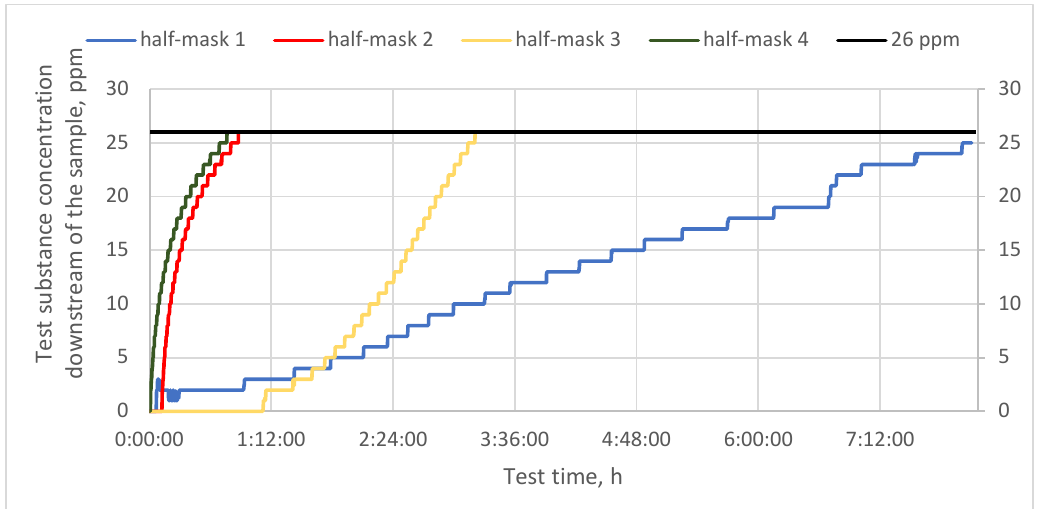
Figure 4. Protection time against toluene for half-masks incorporating different types and quantities of carbon sorbents.